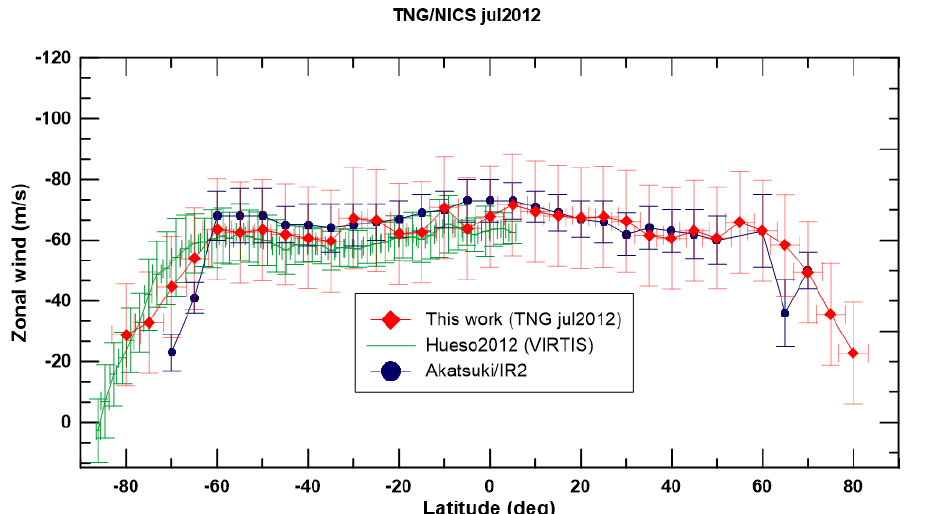
Figure 12. Latitudinal profile of the zonal wind at the bottom cloud deck on Venus ( ∼ 48 km of altitude), obtained using ground-based, near-infrared observations (shown as red diamonds) from the Telescope Galileo (TNG) and the near-infrared camera (NICS). The results shown here are the averaged outcome of a 5 ◦ binning in latitude made from all our measurements and comprising all observational days (11–13 July 2012). For comparative reasons, we also present the latitudinal profile of the zonal wind obtained using space-based data from the infrared channels of VIRTIS instrument from Venus Express space probe (green in the figure, from Hueso et al. [21]) and from the IR2 camera on the Akatsuki orbiter (blue dots, Peralta et al. [22]). We note that VEx/VIRTIS results only cover the southern hemisphere of Venus due to orbital constraints that allowed the obtention of suitable images for performing cloud tracking, only in the southern hemisphere, while the Akatsuki’s equatorial orbit enable the probing of both hemispheres of Venus. For an interpretation of the references to colour in this figure caption, the reader is referred to the web version of this article